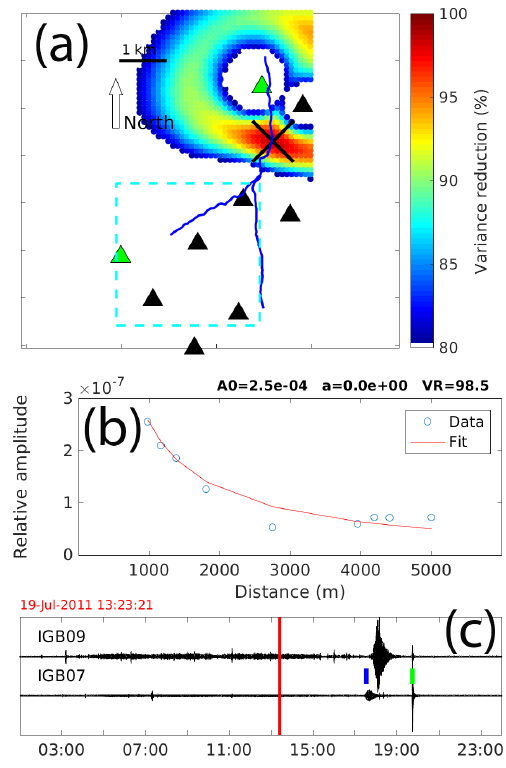
Figure 8. Same as Fig. 7, except during a noise window before the debris-flow